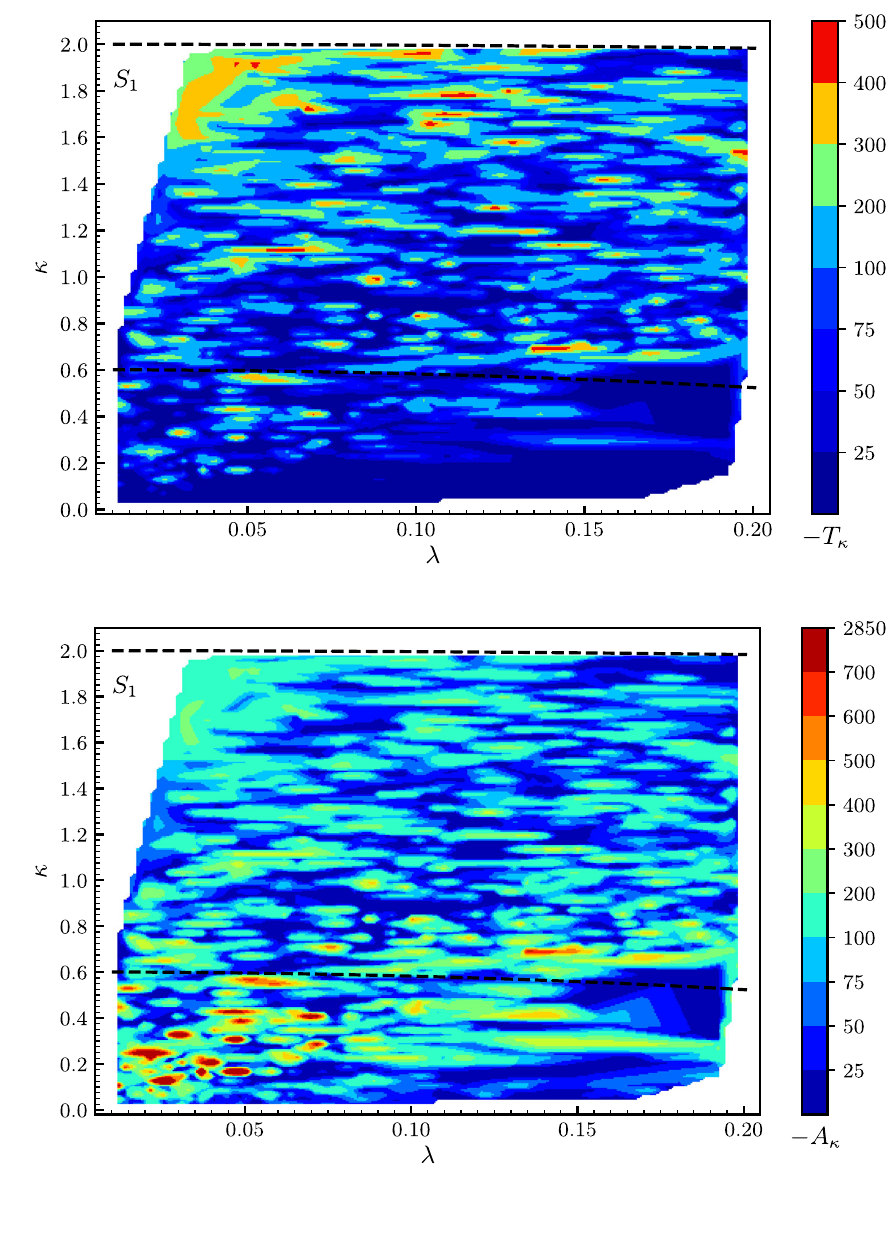
Fig. 22 The same as in Fig. 16, but the colours indicate different low-energy values of the trilinear soft terms T κ